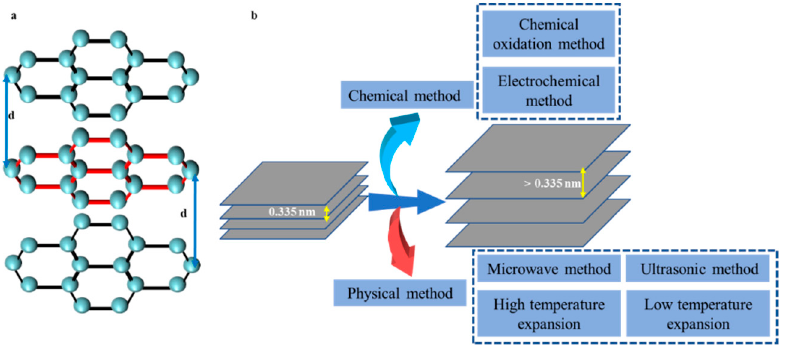
Figure 3. A brief diagram of structures of EG ( a ) and preparation of EG ( b ) [40]. Reprinted with permission from Reference [40]. 2021, RSC. permission from Reference [40]. Copyright 2021